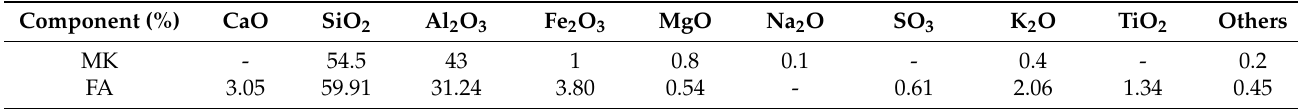
Table 1. Mass fraction of chemical composition of metakaolin and fly